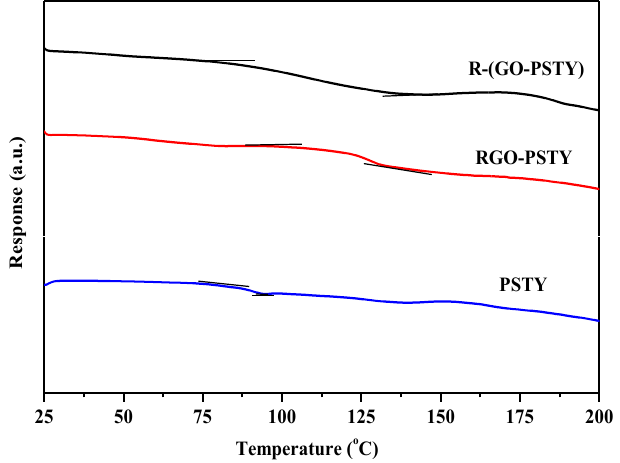
Figure 7. DSC thermograms of neat PSTY, RGO-PSTY and R-(GO-PSTY)